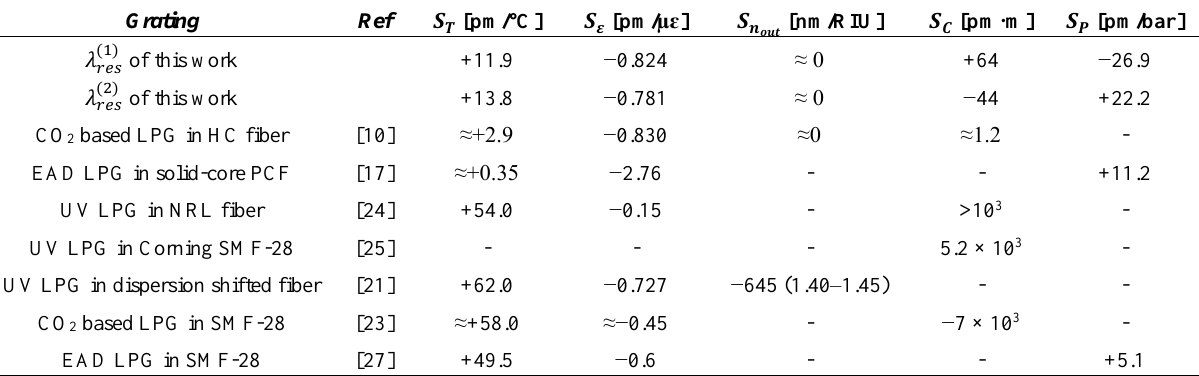
Table 1. Comparison of